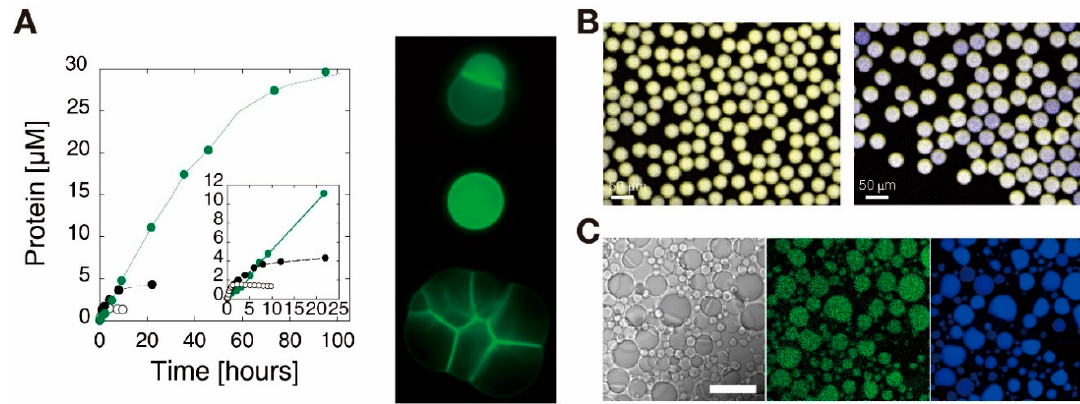
Figure 7. Synthetic gene circuits in cell-sized compartments. ( A ) (left) Expression of eGFP in bulk (open circles) and in a vesicle (closed dark circles), and expression of α -hemolysin-eGFP (closed green circles). (Inset) an expanded view of the first 20 h. (right) Fluorescence microscopy images of α -hemolysin-eGFP expressed in vesicles. Scale bar: 10 μ m. Reproduced with permission from [16]. ( B ) Superimposed false-color images of cyan fluorescent protein (CFP) and yellow florescent protein (YFP) expressed in droplets without (left) or with (right) Ficoll. In the presence of Ficoll, the expression level is highly variable across the population of droplets. Reproduced with permission from [102]. ( C ) Microscopy images of mYPet expression inside an aqueous two-phase system (ATPS) water-in-oil droplets. The images of transmitted light, fluorescence microscopy of mYPet, and fluorescence microscopy of Alexa 647-labeled dextran are presented, from left to right. mYPet is preferentially expressed in the dextran phase rather than the polyethylene glycol (PEG) phase. Scale bar: 25 µ m. Reproduced with permission from [103].